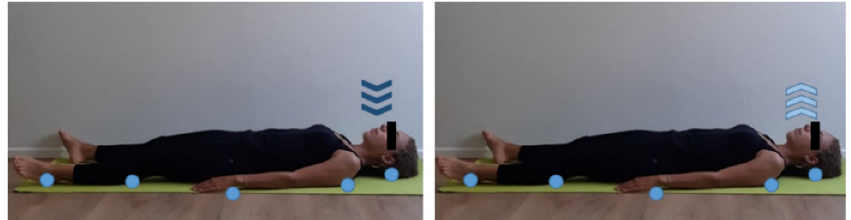
Figure 1. Body perception/awareness exercise on the floor. Supine position, rest straight arms by body sides and hand palms on the floor, eyes closed. Keep a natural pace of inhalation (dark blue arrows) and exhalation (light blue arrows). Focus on body’s contact points on the floor (light blue dots) and analyze differences between right and left hemisoma. Five min work at the beginning of training session. Repeat at the end of training session and compare body perception.